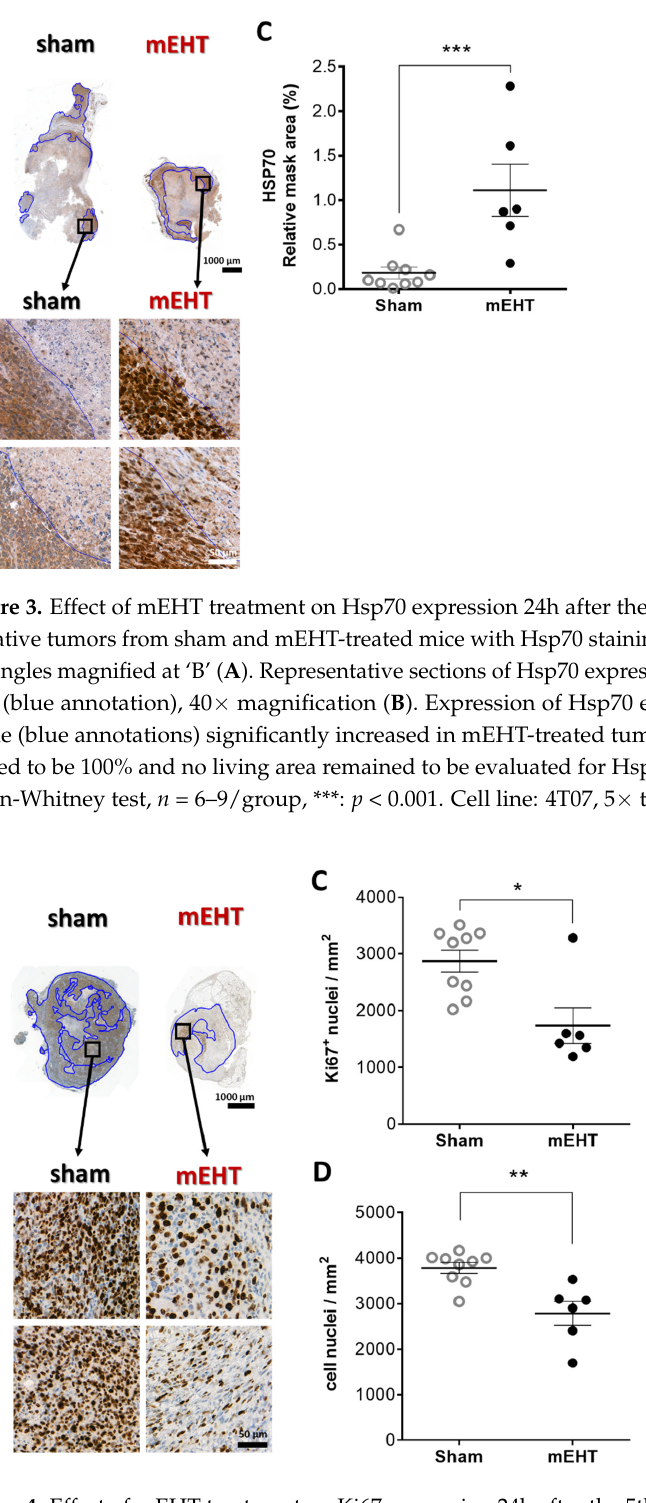
Figure 4. Effect of mEHT treatment on Ki67 expression 24h after the 5th mEHT treatment. Repre- sentative tumor sections from sham and mEHT-treated mice with Ki67 staining ( A , B ). Blue anno- tations: intact area where Ki67 + nuclei were evaluated (0.9× magnification, black rectangles magni- fied at ‘B’ ( A ), 40× magnification ( B )). Area-proportional number of strongly Ki67 positive ( C ) and all nuclei in the intact tumor area ( D ). Mean ± SEM, Mann-Whitney test, n = 6–9/group, *: p < 0.05, **: p < 0.01. Cell line: 4T07, 5× treated. Cell line: 4T07, 5 ×